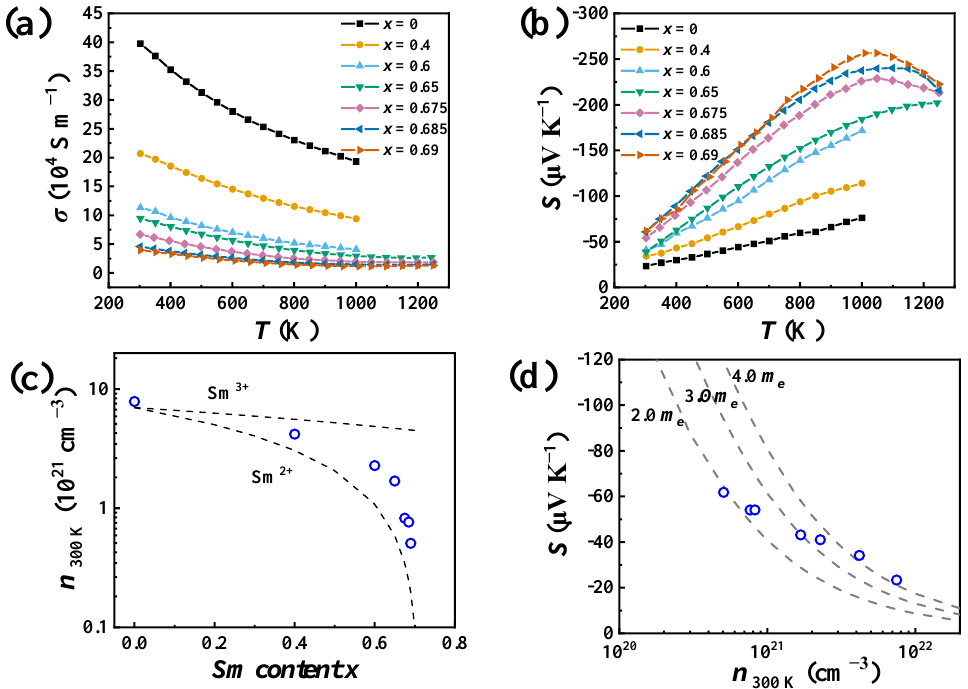
Figure 2. Temperature dependence of ( a ) electrical conductivity σ ; ( b ) Seebeck coefficient S for the La 3 − x Sm x Te 4 /10 vol.% Ni composites ( x = 0, 0.4, 0.6, 0.65, 0.675, 0.685, 0.69). ( c ) Room temperature Hall carrier concentration n 300K as a function of Sm content x . The black dashed lines represent the theoretical carrier concentration calculated from nominal composition with Sm 2+ and Sm 3+ doping, respectively. ( d ) Room temperature S as a function of n 300K for all samples. The gray dashed lines are calculated by the single parabolic band model with different effect masses m * (2.0 m e , 3.0 m e , and 4.0 m e ).